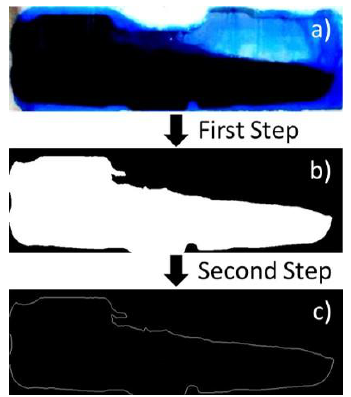
Figure 3. Image post-processing: ( a ) initial picture, ( b ) first elaboration, ( c ) free surface of the flow.